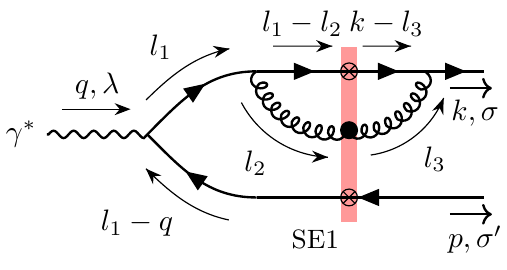
Figure 7 . Gluon self energy with gluon crossing the shock